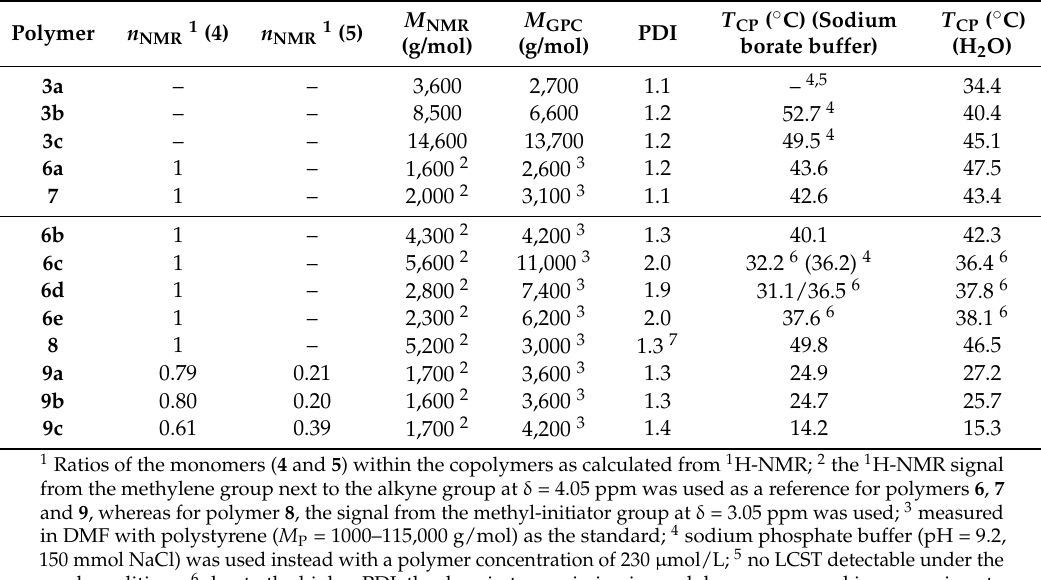
Measured T CP for the synthesized poly(methoxy diethylene glycol)acrylates ( 3 ), poly(2-isopropyl-2-oxazoline) (P i PrOx) ( 6 – 8 ) and P( i PrOx- n BuOx) ( 9 ) in sodium borate buffer and in water. For the homopolymers, 1 wt % solutions were used, whereas for the copolymers, 0.25 wt % solutions were used due to poor solubility in water. The samples were heated at a rate of 0.5 K/min. PDI = Polydispersity